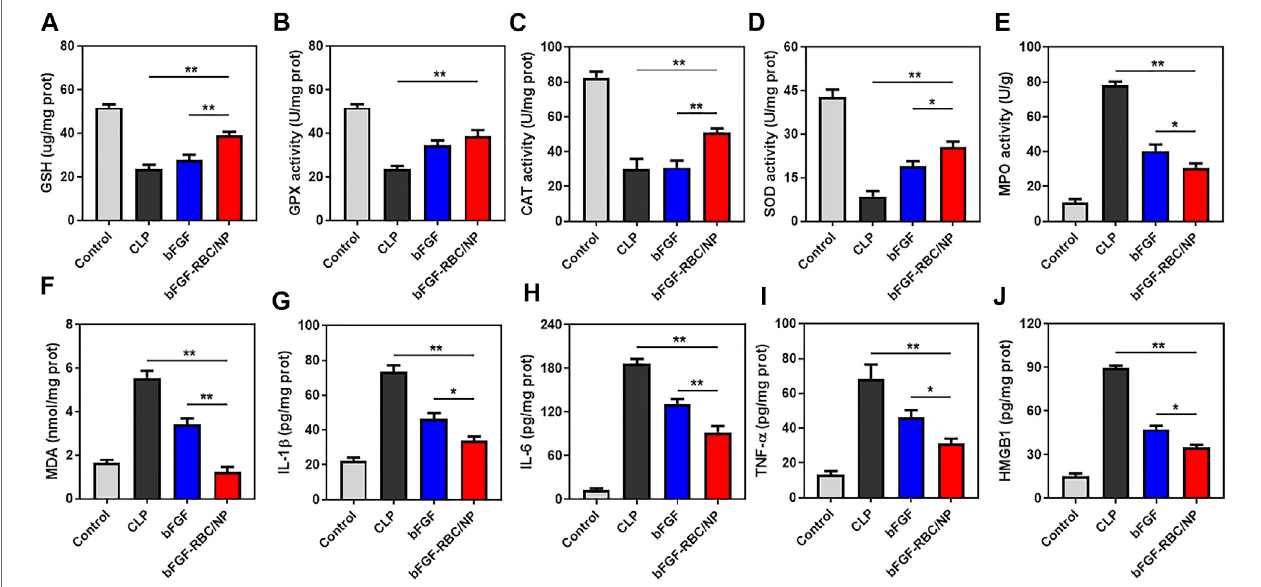
FIGURE 7 | In vivo antioxidant and anti-in fl ammatory effects of bFGF-RBC/NP. The levels of (A) GSH, (B) GPX, (C) CAT, (D) SOD, (E) MPO, and (F) MDA in heart tissues. The contents of (G) IL-1 β , (H) IL-6, (I) TNF- α , and (J) HMGB1 in heart tissues. Data are expressed as the mean ±SD ( n = 3). * p < 0.05 and ** p < 0.01.